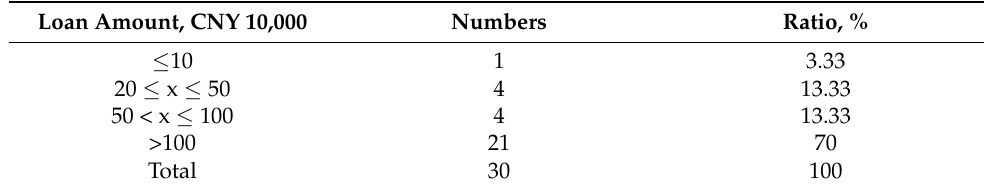
Table 2. Default amount of farmland mortgage loans with the borrower being a company or agricul- tural operation